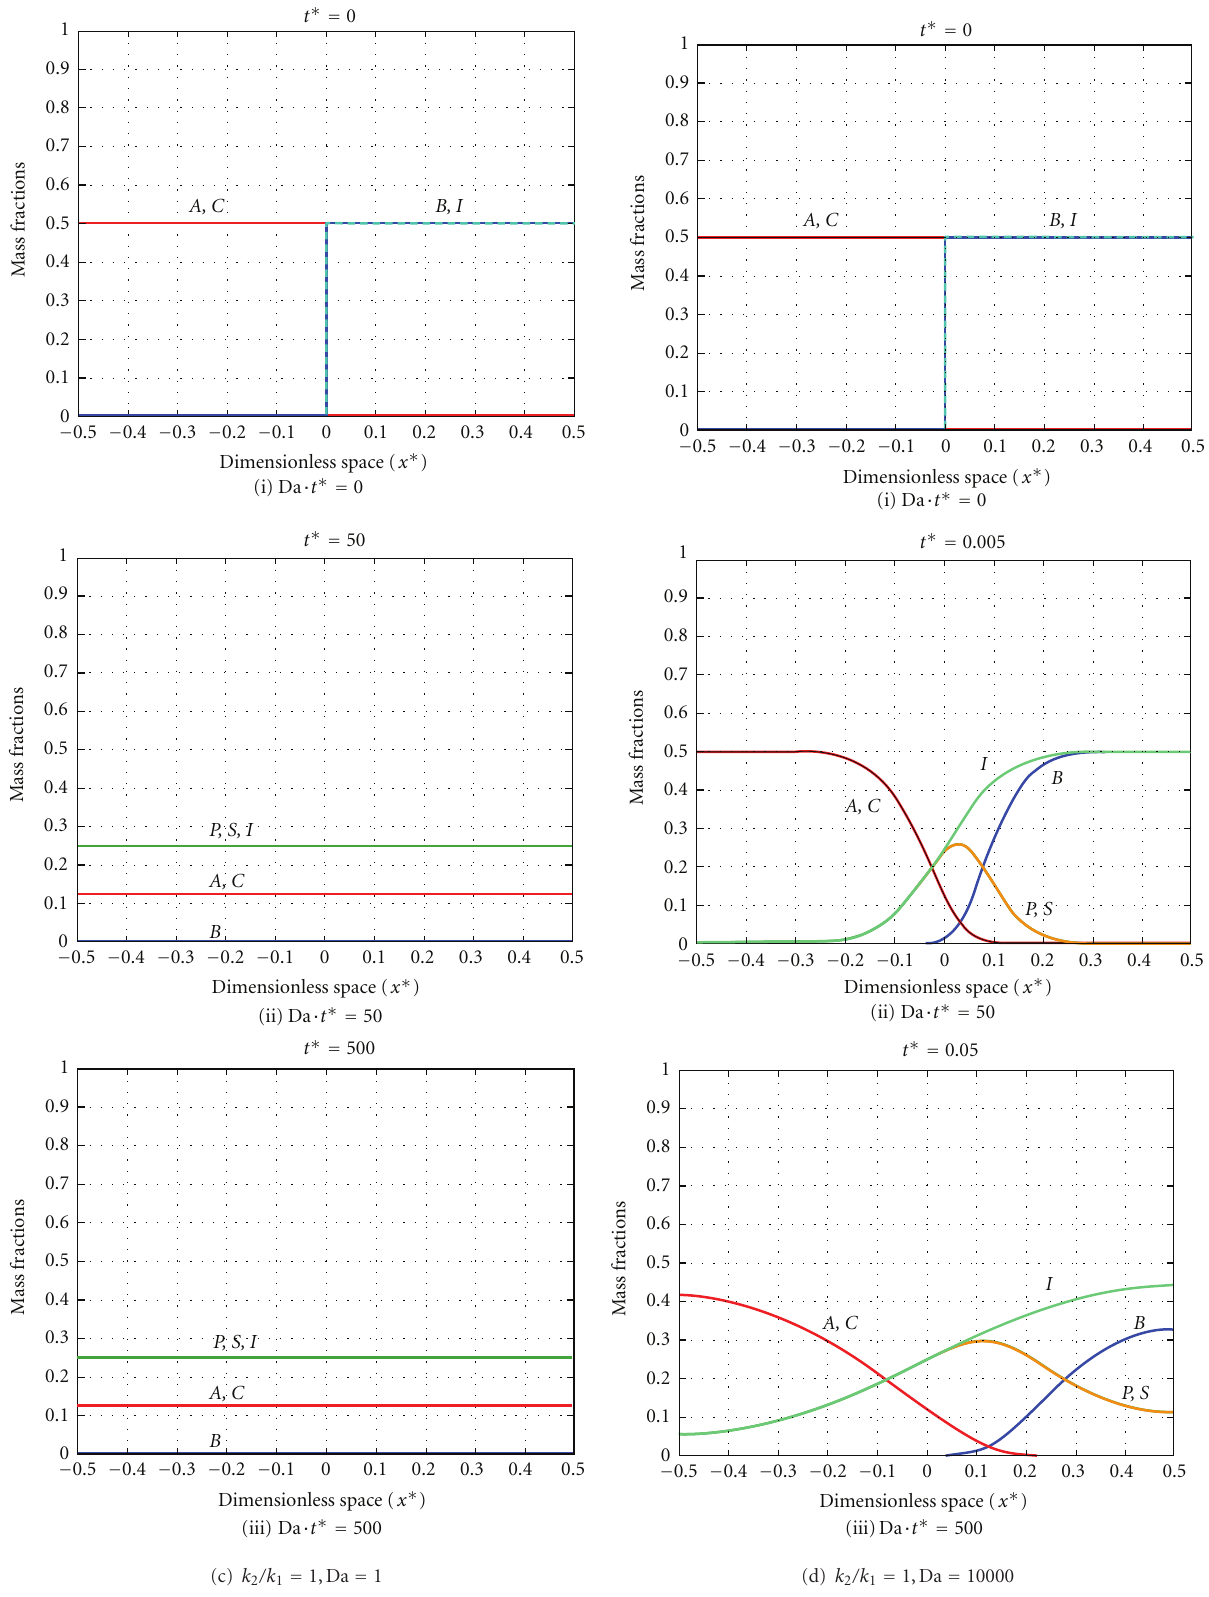
Figure 3: Spatial and temporal evolution of mass fractions for C-P cases (a) Case 1 ( k 2 /k 1 = 10 − 5 ,Da = 1); (b) Case 2 ( k 2 /k 1 = 10 − 5 ,Da